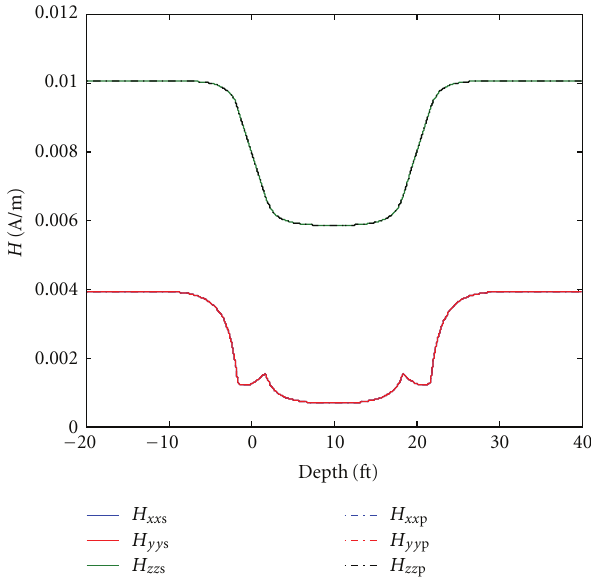
Figure 9: Comparison of the simulated results (5000 points) from the serialized and parallelized